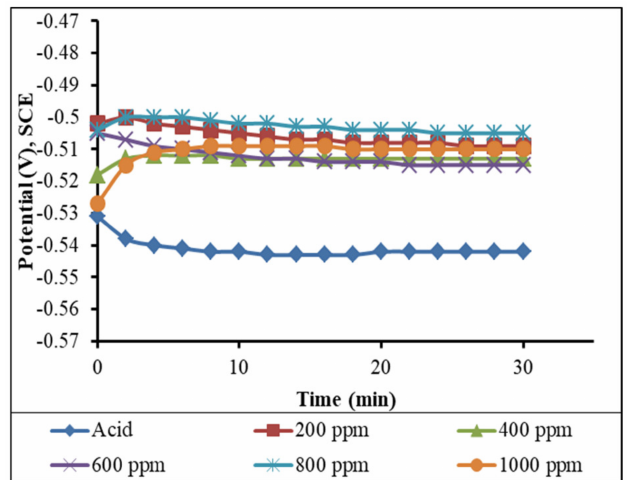
Figure 15. Variations of the OCP with the time of immersion of the mild steel in the different concen- trations of inhibitors in the 1 M H 2 SO 4 solution (measured after 3 h of immersion in the solutions). The polarization of the mild steel samples in the acid and various inhibitor concen- trations (200, 400, 600, 800, and 1000 ppm) was accomplished by applying ± 350 mV in both anodic and cathodic directions using a potentiostat. The Evans diagram and Tafel extrapolation (Figure 16) show that the reduction in current density with the addition of an inhibitor signifies that the MS surface was covered with inhibitor molecules, resulting in a tiny active site for the